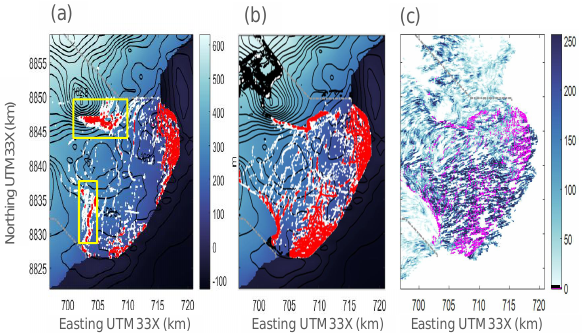
Figure 5. Crevasse distribution from HiDEM on (a) August 2012 and (b) August 2013 and (c) satellite observation. The colour of the underlying image in (a) and (b) shows the surface elevation of the glacier. Bedrock topography contours are shown in black with a ∼ 23.7m interval. All the dots in both (a) and (b) , regardless of the colour, indicate the modelled crevasse distribution from HiDEM. The red dots mark the cut-through crevasses. The red dots in the yellow boxes in (a) are the ones referred to as cut-through crevasses above the subglacial valley margins and are used for calculating the flow paths of the surface melt reaching the bed. The black dots in (b) (upper-left and lower-left corners) mark crevasses produced due to boundary effects in the model (Sect. 4.2). They are eliminated from the crevasse map. The rest of the crevasses are marked with white dots and are mostly shallow crevasses, hence irrelevant to water routing. The cartographic representation of the observed crevasse orientation on 8 August 2013 is shown in (c) (colour-coded with detecting intensity in the background). The magenta colour shows the area where modelled and observed crevasse match. The basin side boundary is outlined with a grey dashed line in all the